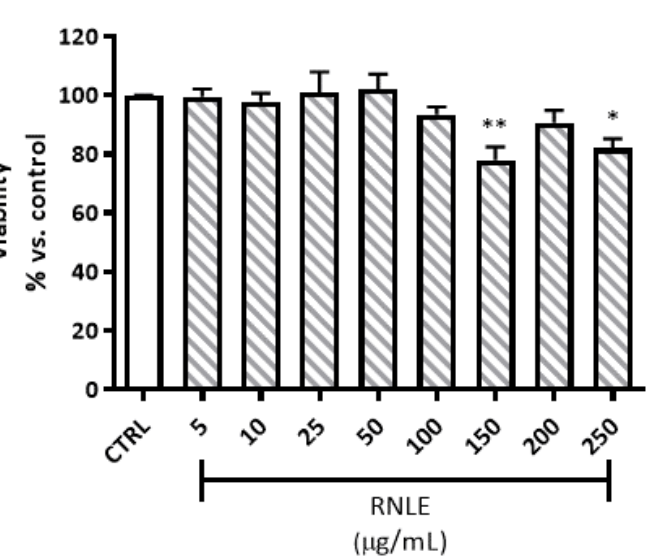
Figure A1. Effect of 24 h RNLE treatment (5–250 µg/mL) on HaCaT cell viability, as measured with Neutral Red Uptake (NRU) assay; * p < 0.05, ** p < 0.01 vs. stimulus.